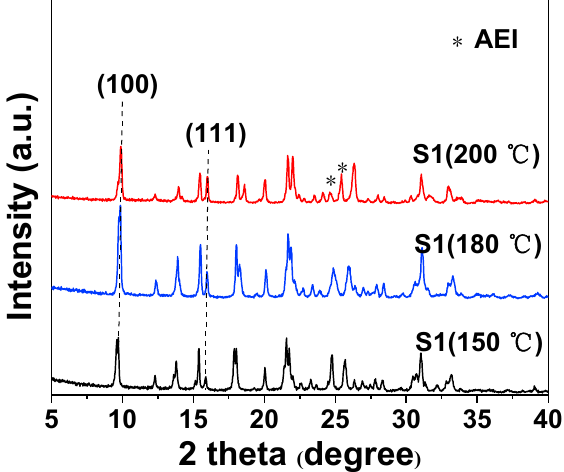
Figure 1. Powder X-ray diffraction (XRD) patterns of the samples synthesized at different crystallization temperatures.